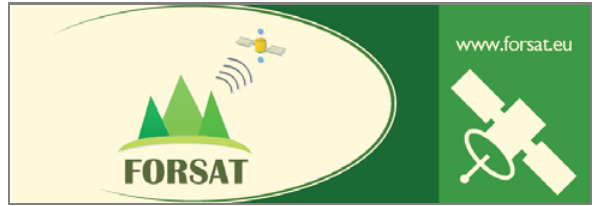
Figure 1. The FORSAT project